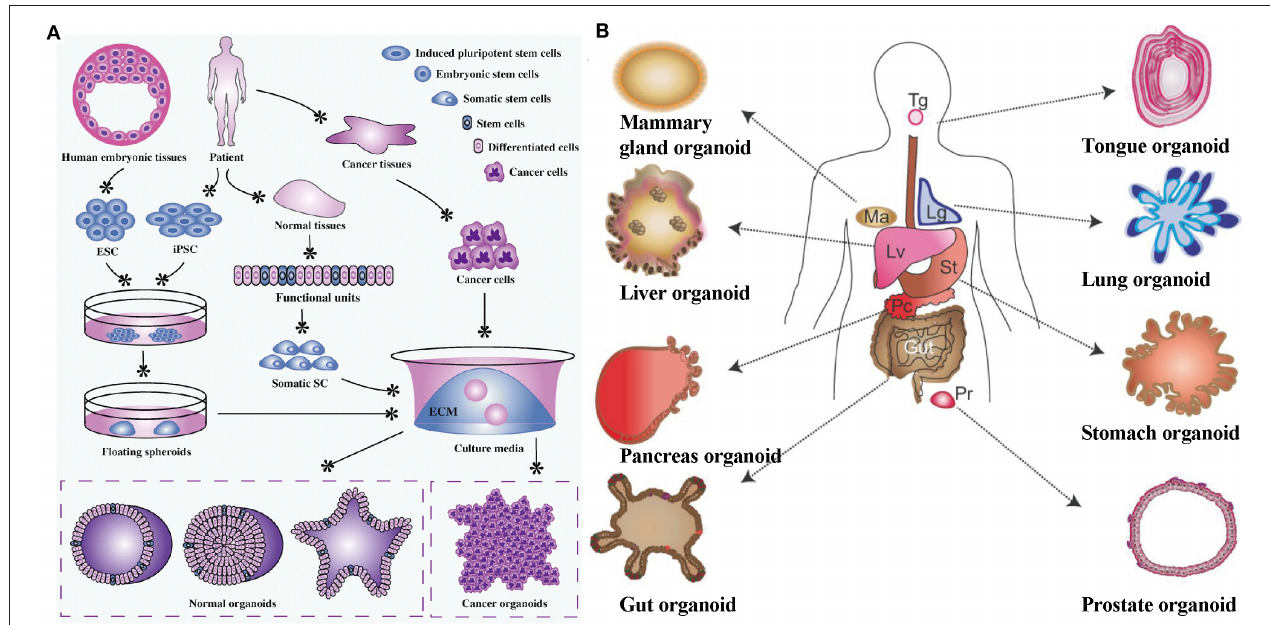
FIGURE 1 | (A) Organoid establishment from stem cells and cancer cells. Embryonic stem cells from human embryonic tissues and induced pluripotent stem cells from adult tissues firstly experience directed differentiation, generate floating spheroids, and subsequently are planted on extracellular matrix in specific culture medium to initiate organoid culture. Primary tissues from patients can be dissociated into functional units, which contain somatic stem cells. These somatic stem cells are enriched and cultured in three-dimensional medium to form organoids. Tumor cells isolated from cancer tissues can also form tumoroids in well-defined three-dimensional culture. Reproduced under the terms of the CC BY Creative Commons Attribution 4.0 International License (Xu et al., 2018). (B) Various types of organoids derived from both isolated adult stem/progenitor cells or from isolated fragments of tissue from the corresponding organ (e.g., intestinal crypts, liver or pancreas ducts). Lg, Lung; Lv, Liver; Ma, mammary gland; Pc, Pancreas; Pr, Prostate; St, Stomach; Tg, Tongue. Reproduced with permission from COMPANY OF BIOLOGISTS ( Huch and Koo,